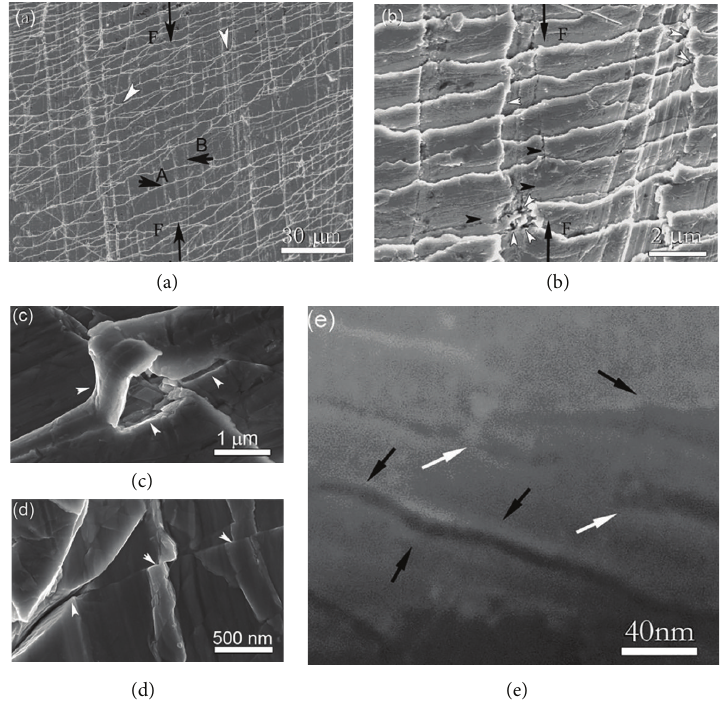
Figure 6: SEM side-view images of a deformed Pd 81 Si 19 BMG specimen with a plastic engineering strain over 70% (a) × 2 K, (b) × 20K, (c) × 100K, (d) × 50K, and (e) × 1000